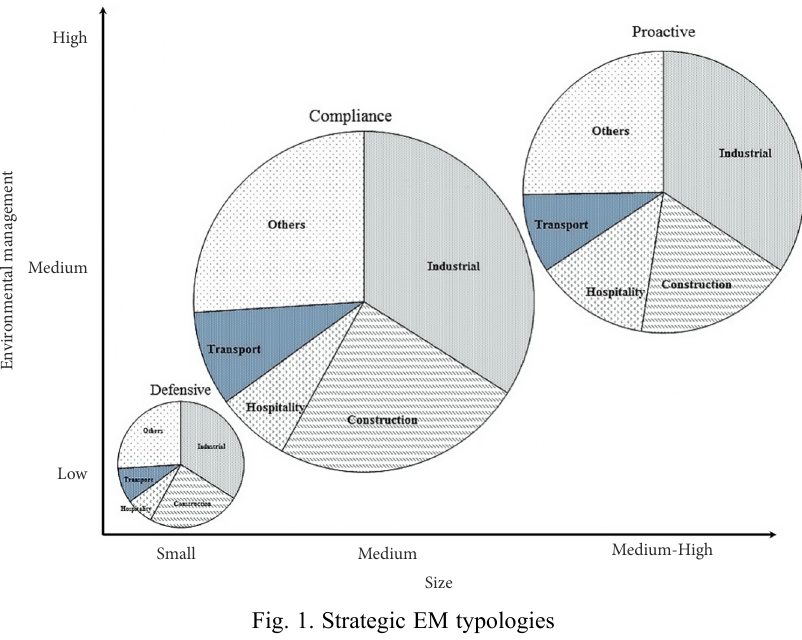
Fig. 1. Strategic EM